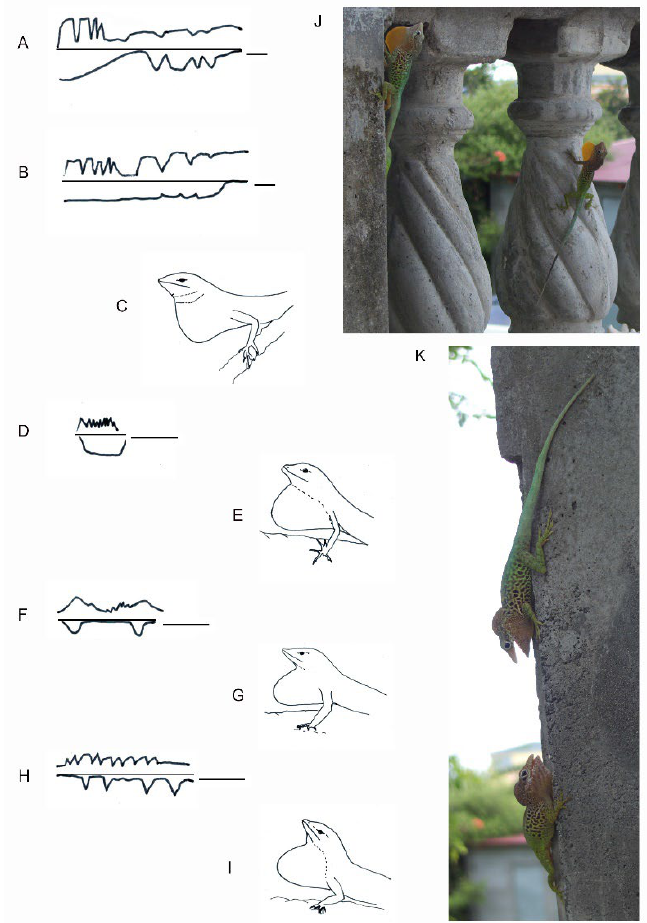
Figure 16. The dewlap exhibition associated with whole body movements shows different patterns and shapes in Anolis species. ( A , B ) Dewlap and headbob display showing interindividual difference in Anolis aureus (redrawn from [107]). ( C ) Dewlap shape in Anolis aureus . ( D ) Dewlap in Anolis limifrons . ( E ) Dewlap shape in Anolis limifrons . ( F ) Dewlap and headbob display in Anolis opalinus. ( G ) Dewlap shape in Anolis opalinus . ( H ) Dewlap and headbob display in Anolis sagrei . ( I ) Dewlap shape in Anolis sagrei . ( J ) Posture of maximum dewlap extension in Anolis marmoratus (Guadeloupe, courtesy L. Legendre, Guadeloupe). ( K ) The throat in Anolis can be variably extended during encounters as shown in Anolis marmoratus (courtesy L. Legendre, Guadeloupe), suggesting possible neuromotor control of throat extension under sensory and internal (e.g., hormonal) behavioral control. ( D , F , H ) are redrawn from [108]. The bar in ( A , B ): 1 s; the bar in ( D , F ) and ( H ): 7 s.